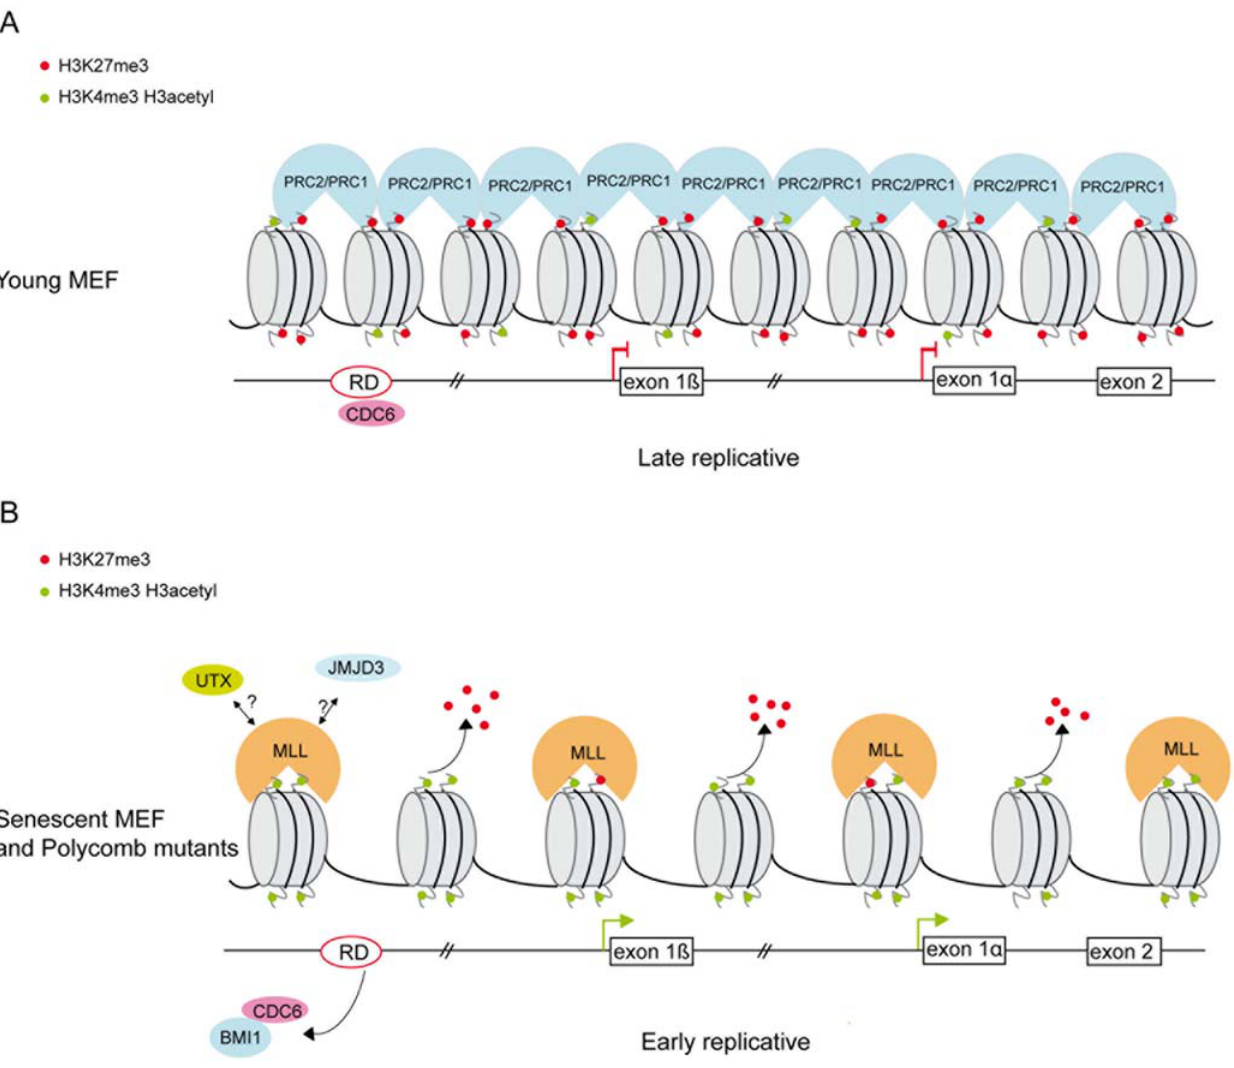
Figure 6. Model for Pc-G and MLL1 proteins in regulation of cellular senescence at the INK4a/ARF locus. (A) In young proliferating cells, the PRC2 complex is bound at RD and at the INK4a/ARF locus and maintains the levels of H3K27me3. This allows the association of M33 and BMI1- containing PRC1 complex and repression of the INK4a/ARF genes. (B) In senescent or Polycomb mutant cells binding of EZH2 is lost, leading to the disruption of the PRC2 complex, the loss of H3K27me3 and to the recruitment of the MLL1 protein. We propose a model in which Polycomb/MLL1 and JMJD3 epigenetic modifications at the RD element impact the replication timing and the expression of the locus. Moreover, in senescent cells BMI1 binding is specifically lost at the RD